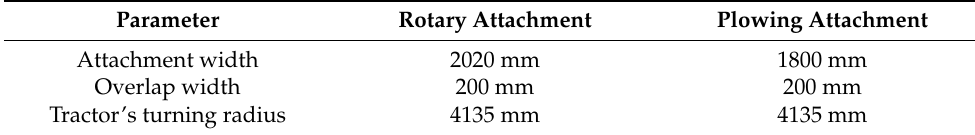
Table 1. The dimensions considered for each attachment type. Parameter Rotary Attachment